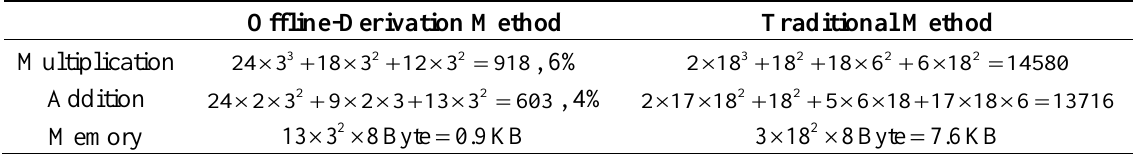
Table 3. Optimization efficiency of